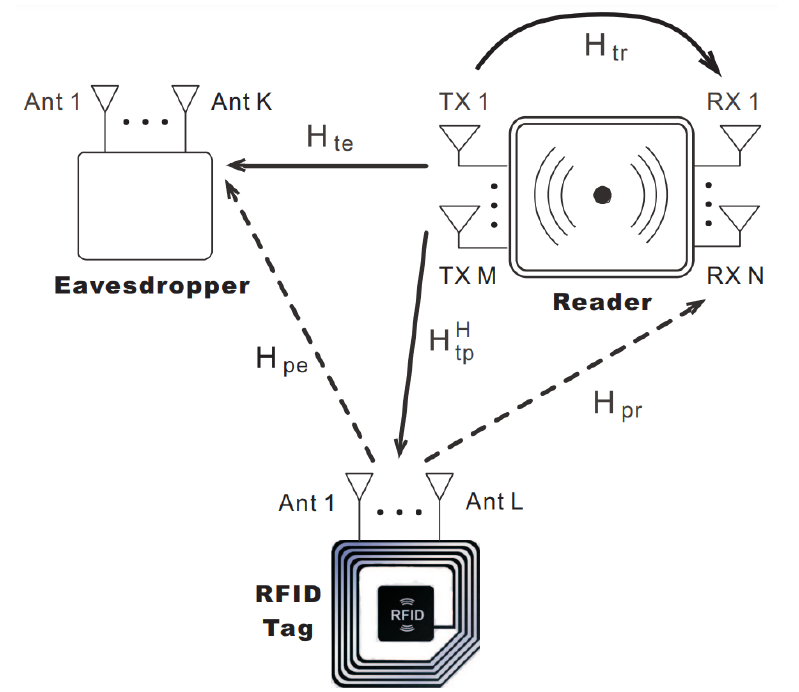
Figure 7. MIMO RFID system with a passive eavesdropper. Reproduced from [60] with permission from IEEE.